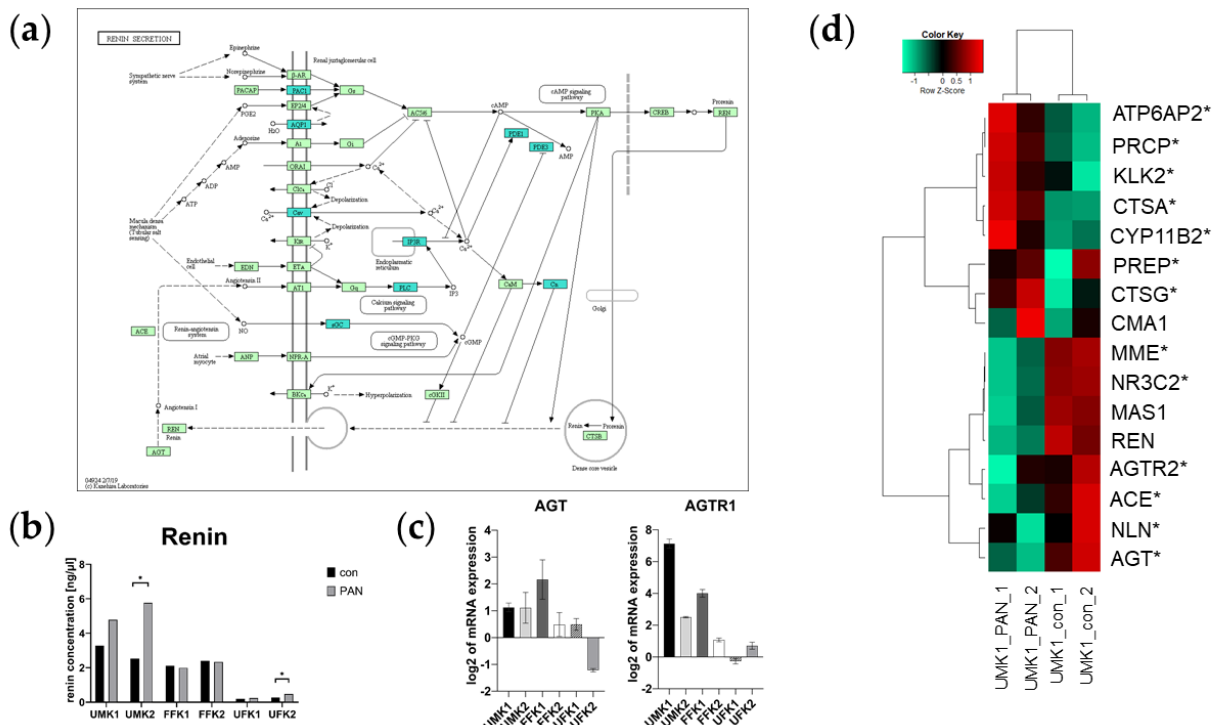
Figure 7. PAN induction affects the RAAS in kidney organoids. ( a ) PAN induces downregulation of genes of the KEGG pathway renin secretion. Downregulated genes are marked in blue. ( b ) Renin concentration (ng/µL) in conditioned media of untreated and PAN-treated kidney organoids. Significance is determined by α-value ≤ 0.05. ( c ) Expression of RAAS-associated AGT and AGTR1 is upregulated in PAN-induced kidney organoids. Error bars depict the standard error. ( d ) Pearson’s heatmap depicting the expression of RAAS-associated genes in untreated and PAN-treated kidney organoids.